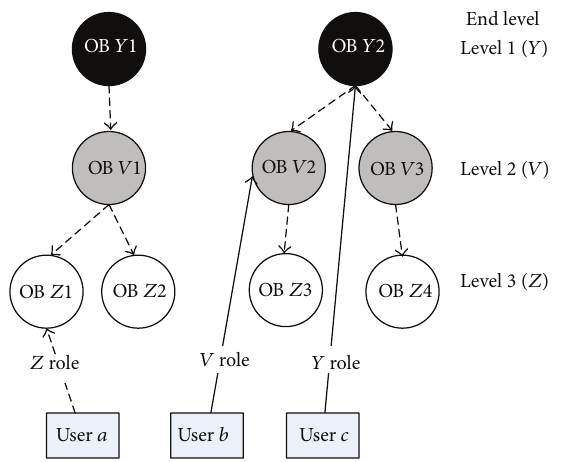
Figure 5: Relations between users and objects in the hierarchical presocial network HPSN.